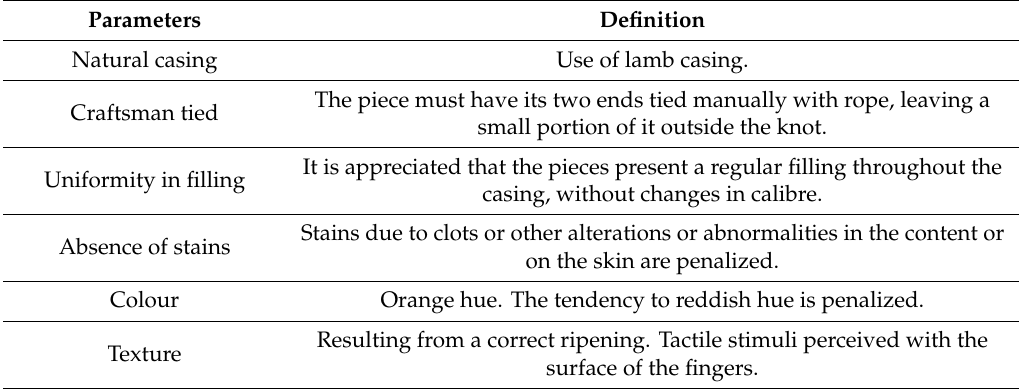
Table A1. Parameters evaluated on the raw-cured product at step 1 of the contest visual evaluation.